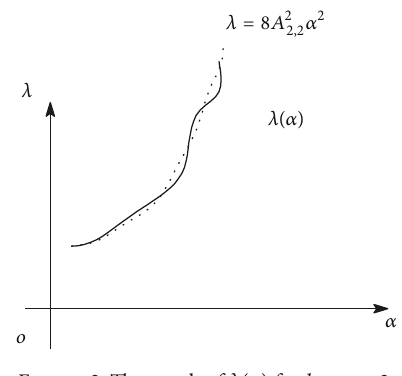
Figure 2: The graph of 𝜆(𝛼) for 𝑘 = 𝑛 = 2